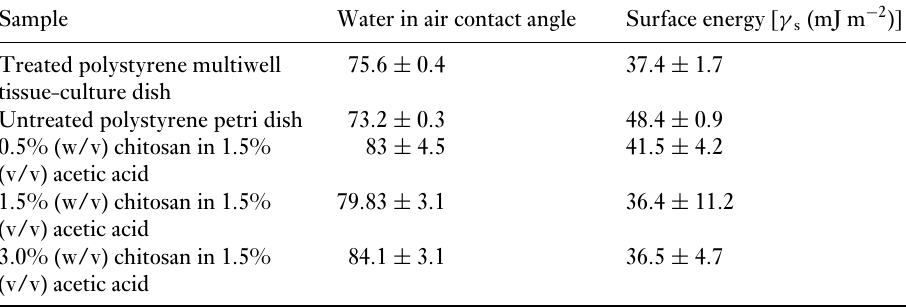
Table 2 Summary of WIA contact angle and SFE of substrates